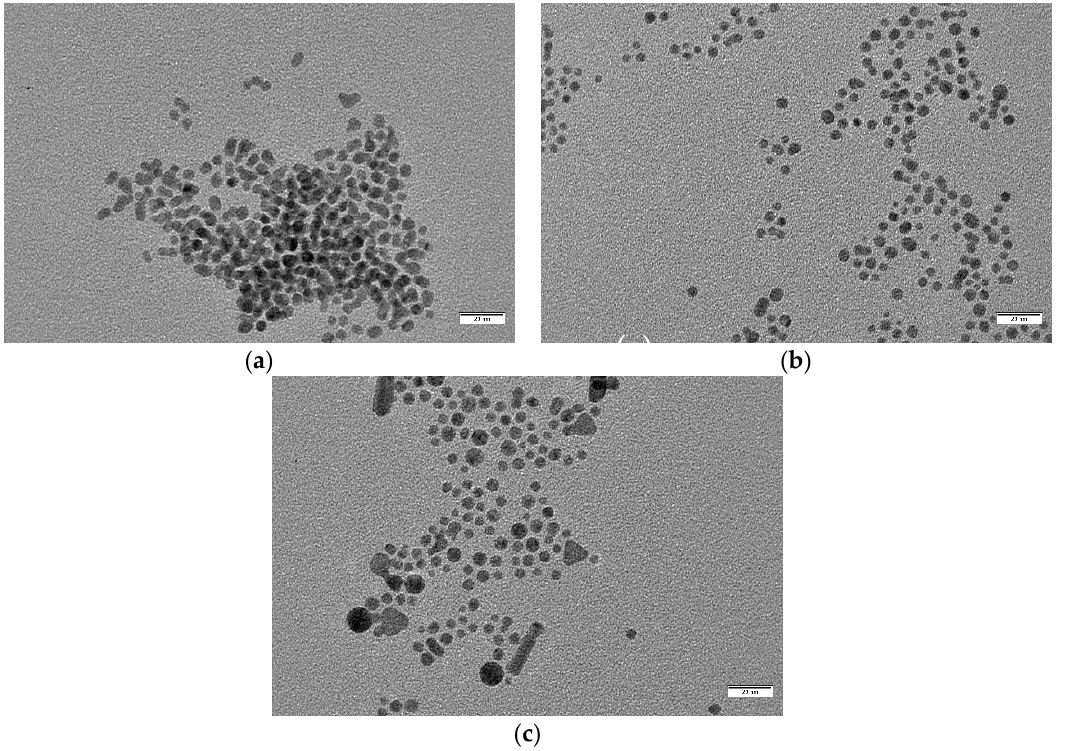
Figure 6. From up to down and left to right: TEM images of samples ( a ) S7, ( b ) S6, ( c ) S5, ( d ) S4, ( e ) S3, and ( f ) S0. All images were taken at the same magnification. Scale bar corresponds to 100 nm.